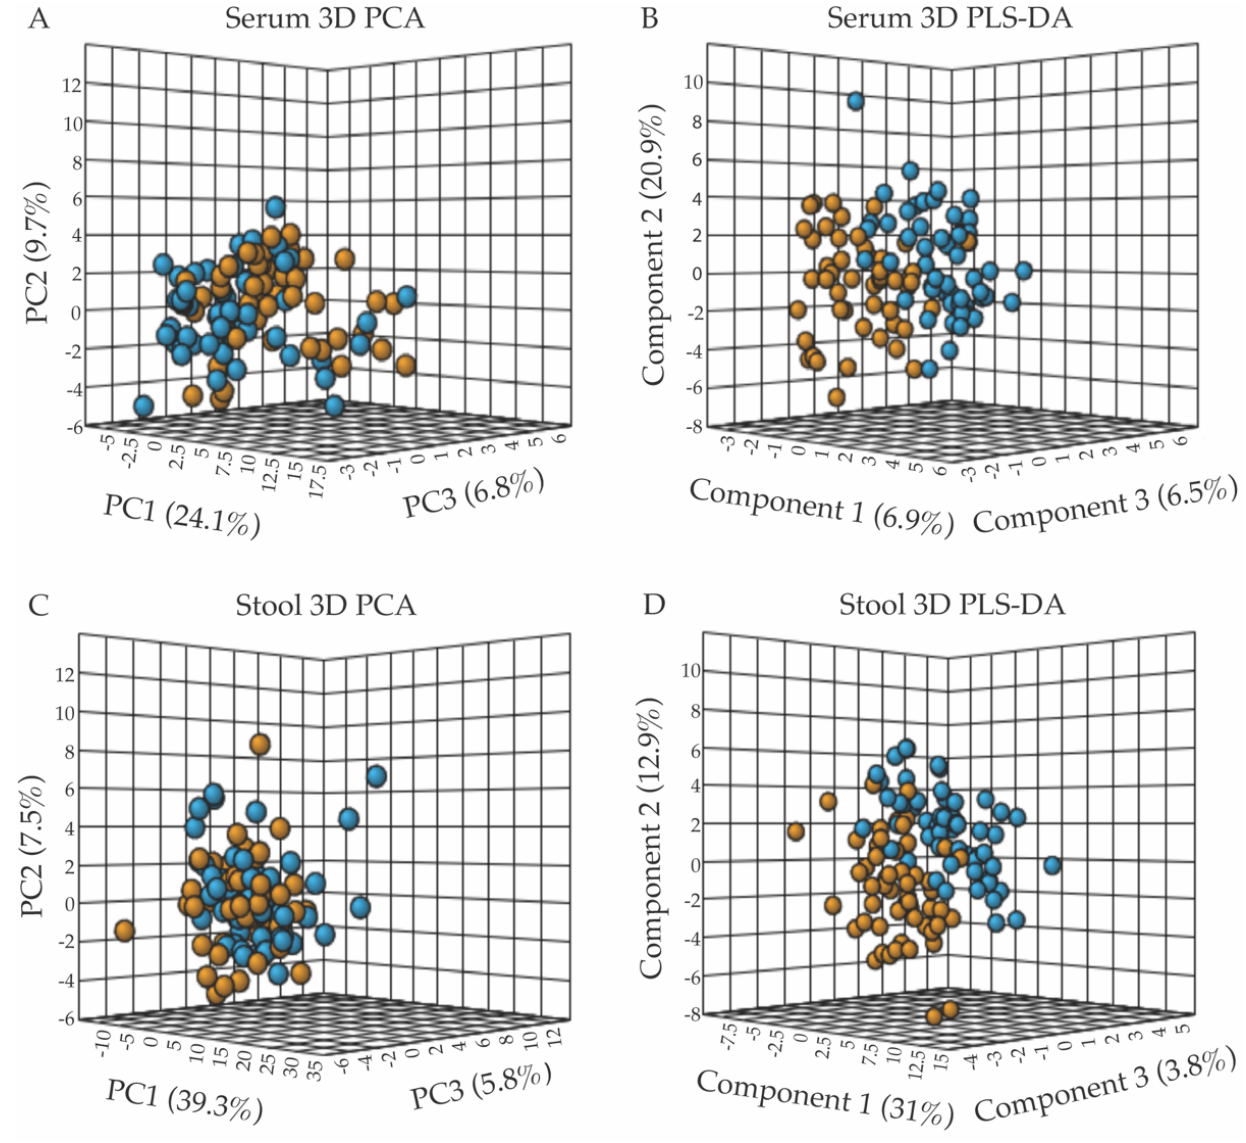
Figure 1. Multivariate statistical analyses of serum and fecal metabolic profiles separate the FD patient population (orange) from the control relative group (blue), with panels ( A , B ) presenting the 3D-PCA and 3D-PLS-DA scores plots from the analyses of serum metabolite patterns, and panels ( C , D ) those from fecal sample analyses. ( A ) 3D-PCA scores plot obtained from the principal component analysis (PCA) of serum metabolite patterns reveals little separation between the FD patients and healthy control relative groups, with PC1, 2, and 3 accounting for 40.6% of the variance. ( B ) 3D-PLS-DA scores plot obtained from partial least-squares discriminant analysis (PLS-DA) of serum metabolites resulted in the separate clustering of the FD patient and healthy relative control groups, with components 1–3 accounting for 34.3% of the variance. ( C ) 3D-PCA scores plot of stool metabolite profiles, revealing minimal separation between groups, with PC1-3 accounting for 52.6% of the variance. ( D ) 3D-PLS-DA scores plot analysis of stool metabolite profiles indicated a clear separation of the FD patient group from the control group based on distinct fecal polar metabolomes, with components 1–3 accounting for 47.7% of the variance. All data shown in Figure 1 (3D-PCA and PLS-DA scores plots) were generated using the MetaboAnalyst v.4.0 software (Edmonton, AB,